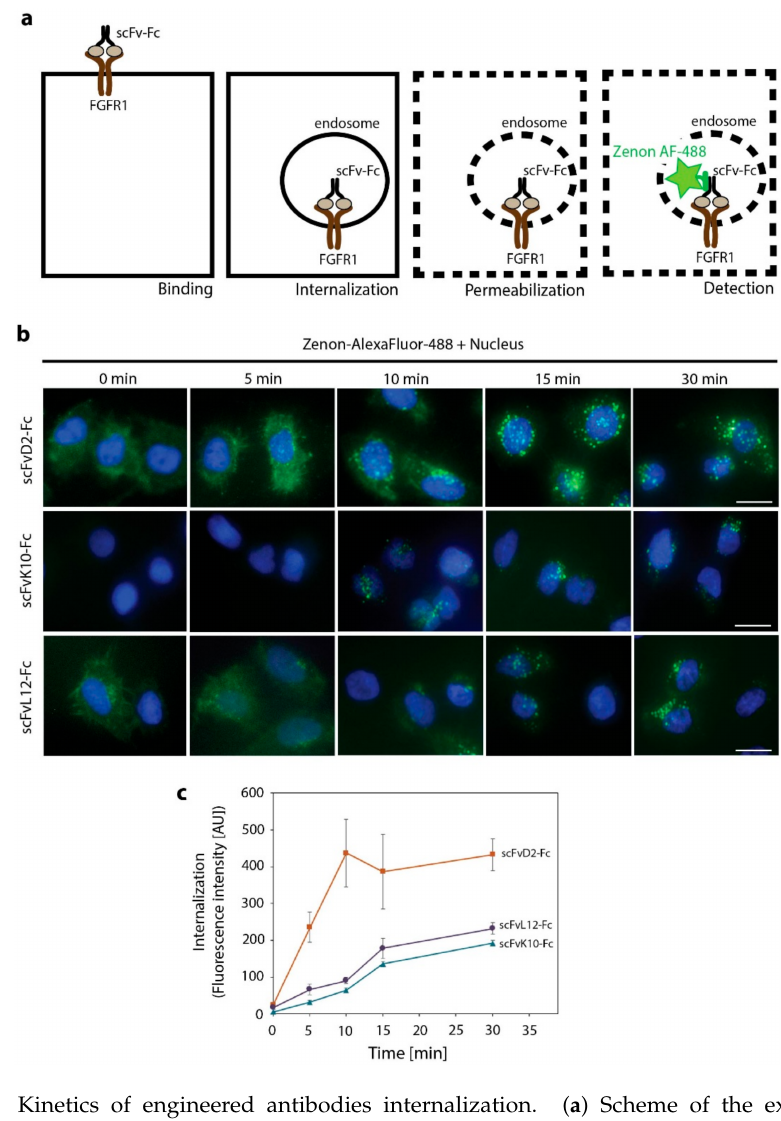
Figure 5. Kinetics of engineered antibodies internalization. ( a ) Scheme of the experimental setup. Non-labeled scFv-Fc proteins were incubated with U2OSR1 cells to allow for binding and internalization. Next, cell surface-bound engineered antibodies were removed by washing, cells were permeabilized and incubated with Zenon-AlexaFluor-488, a fluorescently labeled Fab fragment specifically recognizing Fc fragment of human origin that detects non-labeled, internalized scFv-Fc proteins. ( b ) U2OSR1 cells were incubated with scFv-Fc proteins for various time points and internalized engineered antibodies were detected with Zenon-AlexaFluor-488 (green), as described above. Nuclei were labeled with NucBlue Live (blue). Scale bars represent 20 µ m. ( c ) Kinetics of scFv-Fc proteins internalization. Fluorescence intensity of Zenon-AlexaFluor-488 (visualizing internalized scFv-Fc proteins) was measured within single U2OSR1 cells at various time points. At least 20 cells were measured from three fields of view for each time point. The values represent average fluorescence intensity from three experiments per cell. Error bars represent +/ −